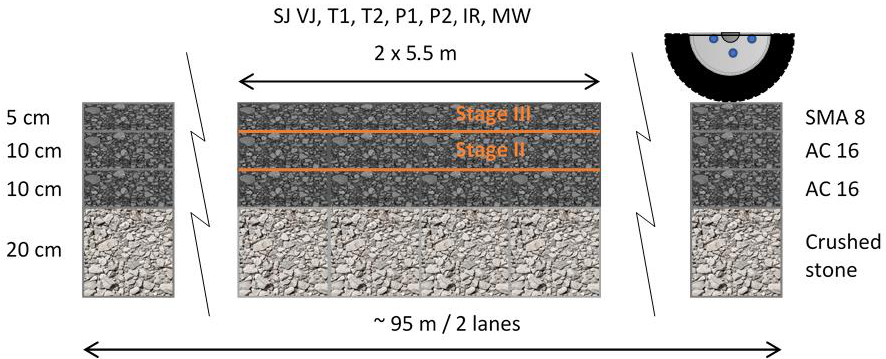
Figure 2. The schematic longitudinal cross-section of the longitudinal joints construction test